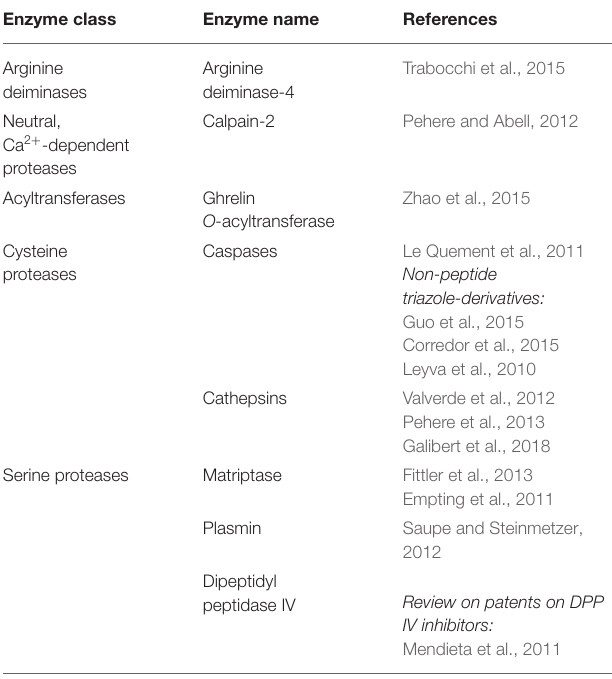
TABLE 6 | Enzymes and corresponding peptidomimetic inhibitors with triazole-modified sequences, described in this review. Enzyme